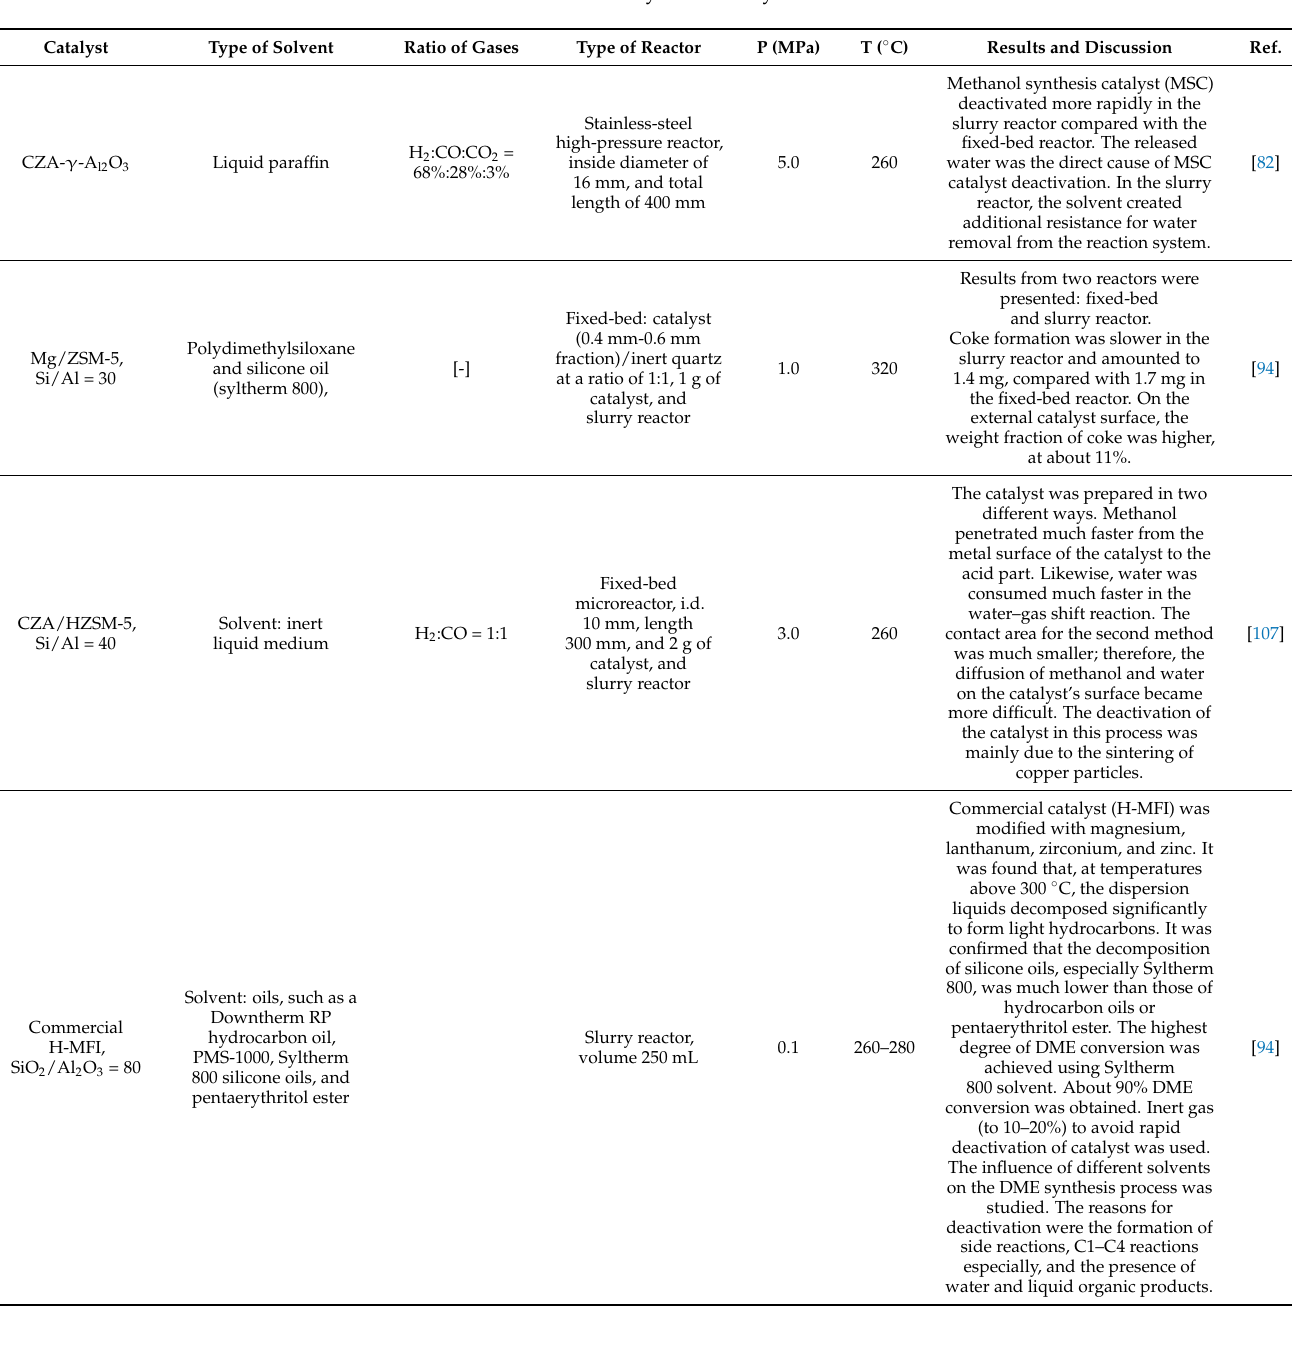
Table 2. Deactivation of the catalysts in slurry